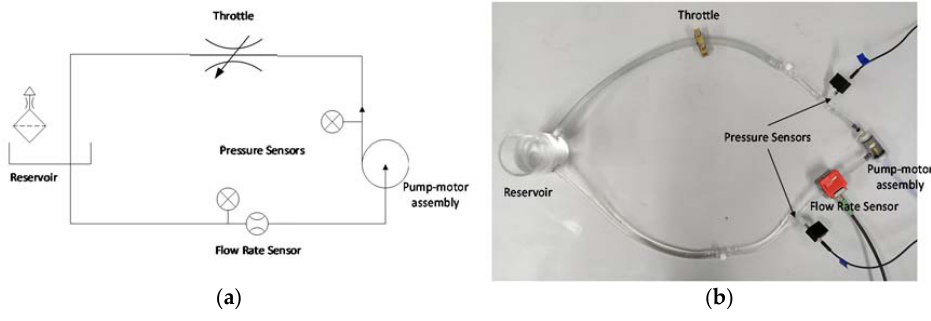
Figure 1. Test circuit: ( a ) Schematic; ( b ) Photograph.